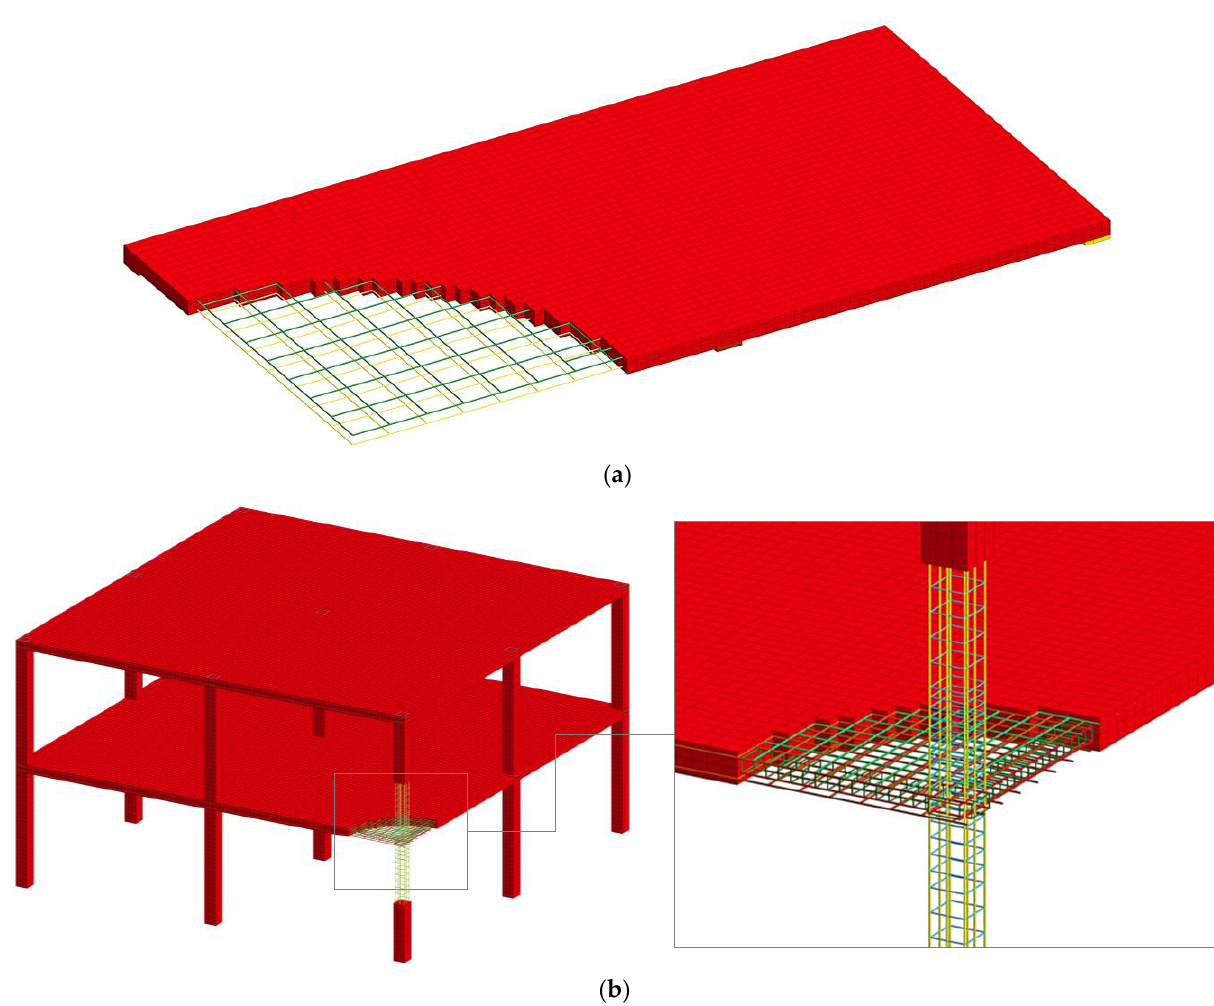
Figure 4. Finite element mesh of flat slab ( a ) and two-story frame ( b ).